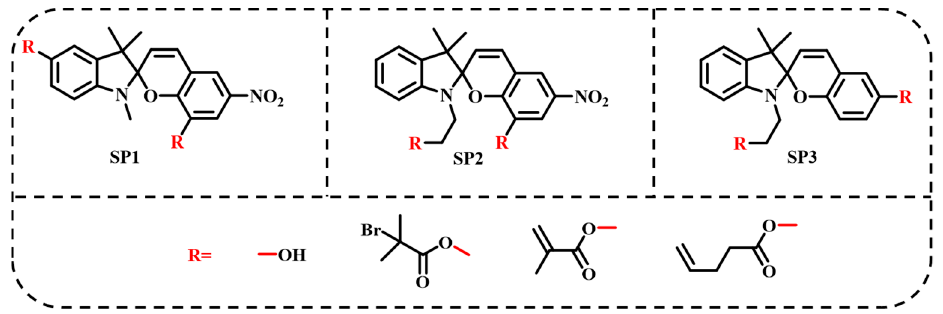
Scheme 1. Three types of SP mechanophores distinguished from their anchoring groups for different functionalization and applications.